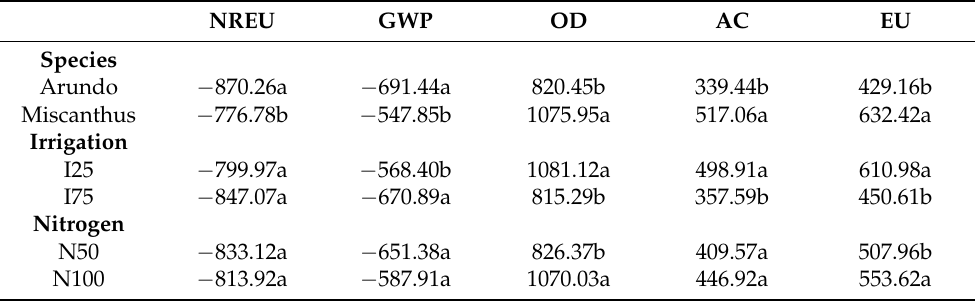
Table 3. Mean separation of main effects on impact categories, expressed in European inhabitant equivalent per 100 TJ of energy consumed in one year of Arundo donax and Miscanthus × giganteus grown under different irrigation levels (I 25 and I 75 ) and nitrogen rates (N 50 and N 100 ). Different letters within main effect indicate statistical different mean ( p ≤ 0.05). NREU GWP